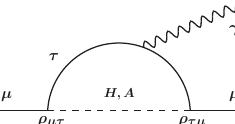
2 anomaly, with ρ τµ , ρ µτ much larger than Equation −